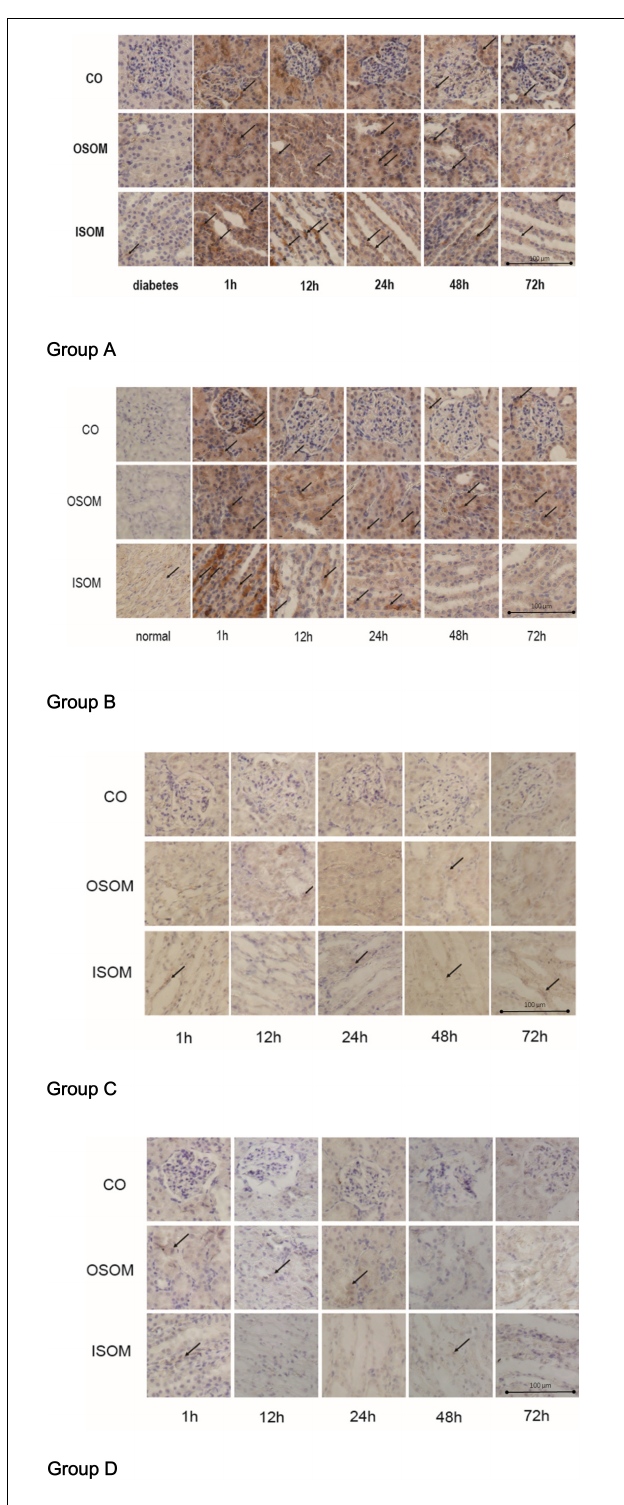
FIGURE 7 | HIF-1 α expression in kidney, × 400. Group A diabetes+CM, Group B normal+CM, Group C diabetes+saline, and Group D normal+saline. The arrows show the strongest staining in one representative scope. CO, cortex; OSOM, outer stripe of the outer medulla; ISOM, inner stripe of the outer medulla; CM, contrast medium; HIF-1 α , hypoxia-inducible factor-1 α